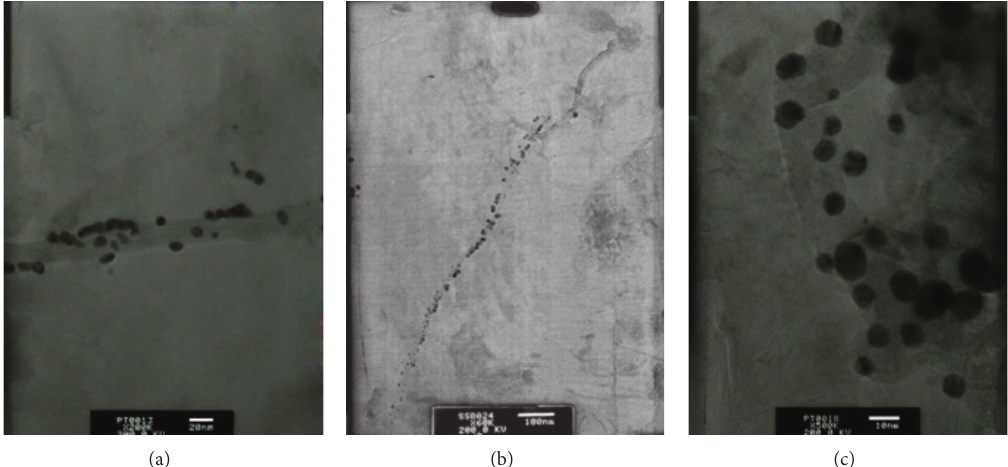
Figure 5: The selected TEM images of (a) Au-CNT, (b) Pt and Pd loaded Au-CNT with a closer TEM image (c).